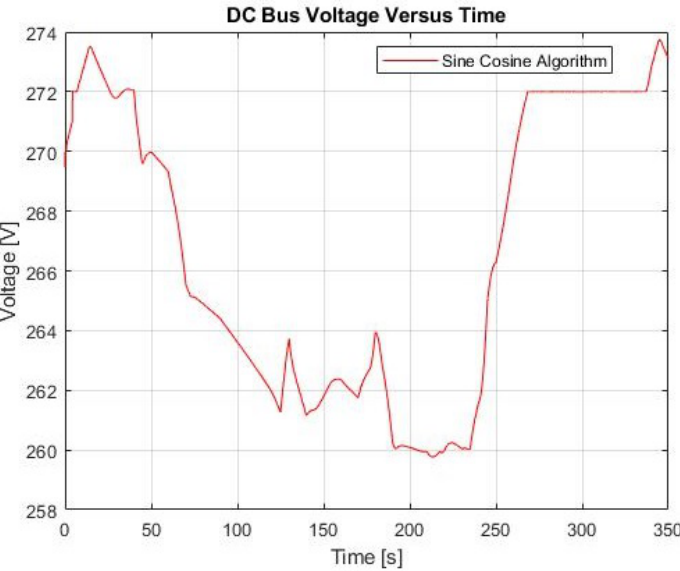
Figure 18. Variation of voltage of DC bus during